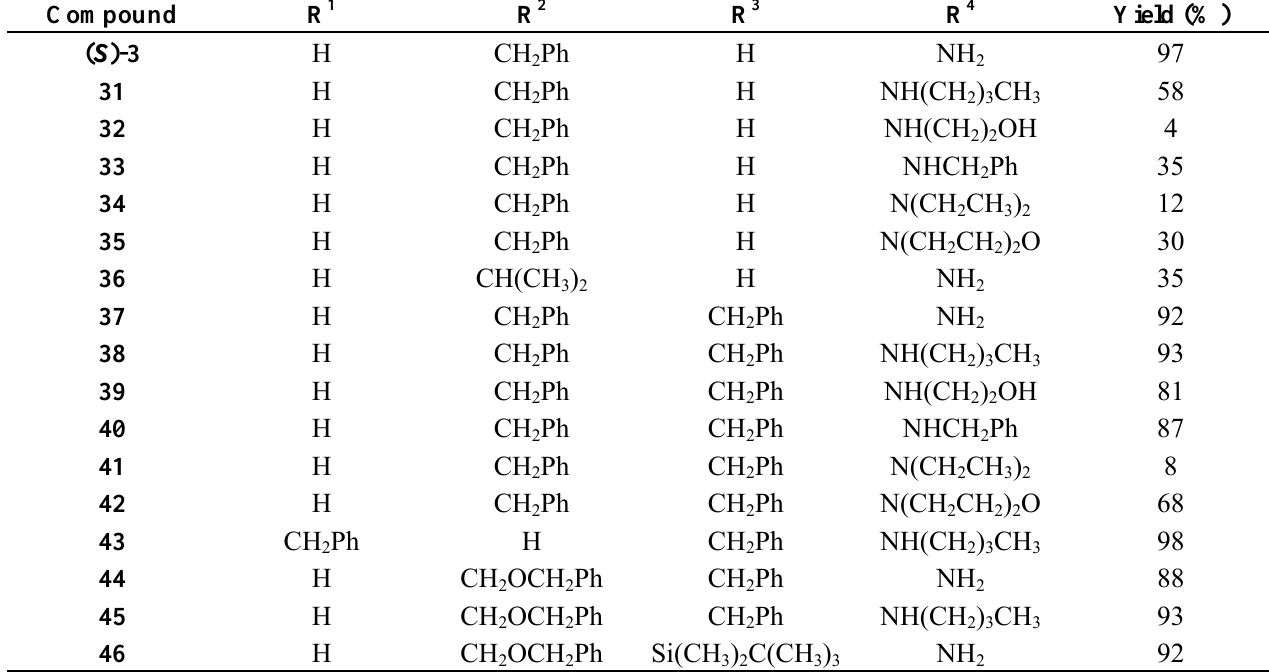
Table 3. Synthesis of